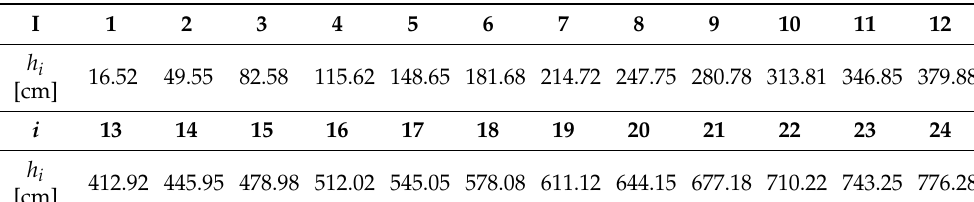
Table 3. Average positions of the radial burnable